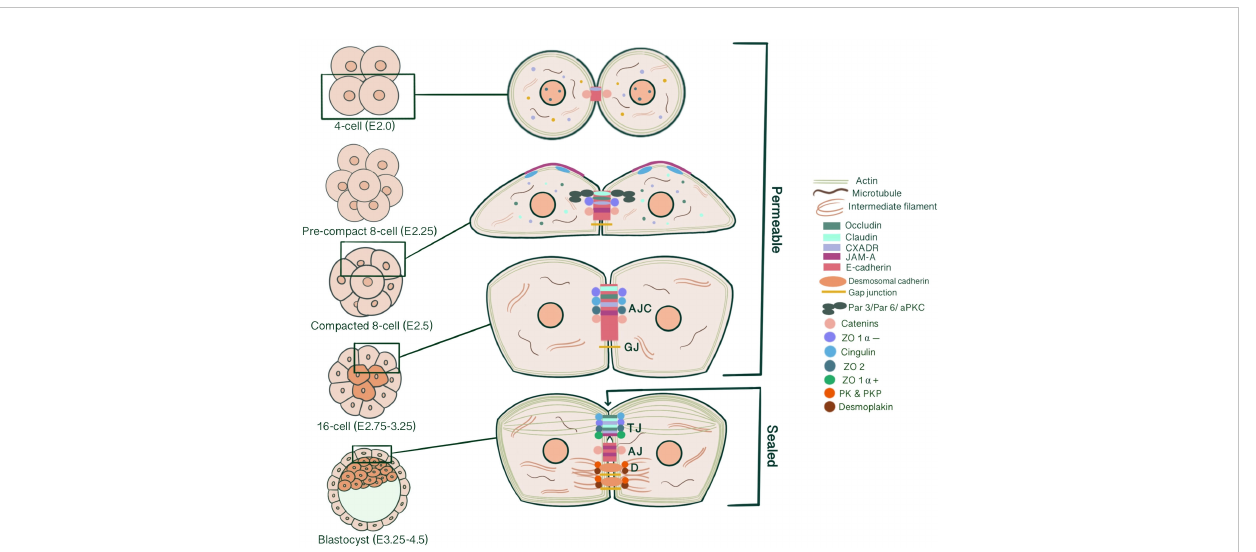
FIGURE 5 Schematic representation of apical junctional complex formation and maturation into distinct TJ, AJ, D, G starting from the 4-cell stage until the blastocyst stage, according to immuno fl uorescence studies from mouse pre-implantation embryos. Following the initial cleavage, until the early 8- cell stage, blastomeres are loosely connected by the E-cadherin-catenin complex localized at cell-cell contact sites. JAM family constituents assemble earlier than other TJ proteins, with CXADR starting to be detected at the 4-cell stage both in the cytoplasm and cell-cell contacts and JAM-A at the precompact 8-cell stage. With compaction, TJ constituents start to assemble in apicolateral contact regions. At the late compacted 8- cell stage, claudin and occludin start to be detected at cell membranes as punctate stains, co-localizing with ZO-1 a -, a - and b -catenin, which together form the permeable AJC. GJIC is also fi rst evident at compacted late 8-cell stage embryos, with Cx43, 31, 31.1 and 45 localizing at membrane appositions. Cytocortical cingulin is present at the apical microvillus pole. Similarly, JAM-A intensity increases at the microvillus pole with compaction. At the 16-cell stage, ZO-2 and cingulin assemble at the contact sites for the fi rst time, co-localizing with E-cadherin. Claudin and occludin evolve to continuous linear bands. Likewise, CXADR is also detected as continuous bands at the morula stage, with decreasing cytoplasmic intensity. Finally, at the 32-cell stage early blastocyst, ZO-1 a + localization initiates TJ/AJ segregation, forming a permeability seal. A functional TJ barrier enables the formation of the blastocoel, which is coordinated with desmosome assembly. Desmosomes start to assemble in TE at 32-cell stage regulated by desmocollin 2 expression and increase with blastocoel expansion, stabilizing TE against fl uid pressure. Simultaneously to junction biogenesis, initial E-cadherin homodimerization triggers cytoskeletal reorganization. Radial arrays of actin fi laments transform into circumferential actin belts below the tight junction barrier, supporting a maturing epithelial characteristic. In addition, intermediate fi laments anchor to desmosomes, which appear as disc-like structures along the entire lateral border. (AJC: apical junctional complex, TJ: tight junction, AJ: adherens junction, D: desmosomes, G: gap